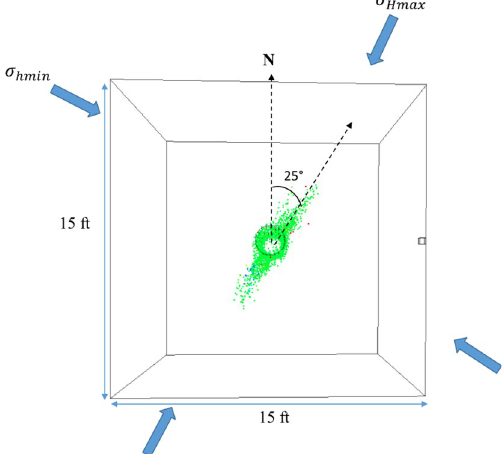
Fig. 19 Top view of tensile fracture propagation (green dots) in the numerical simulation with no natural fracture. Tensile fracture occurs in the direction of the maximum horizontal stress